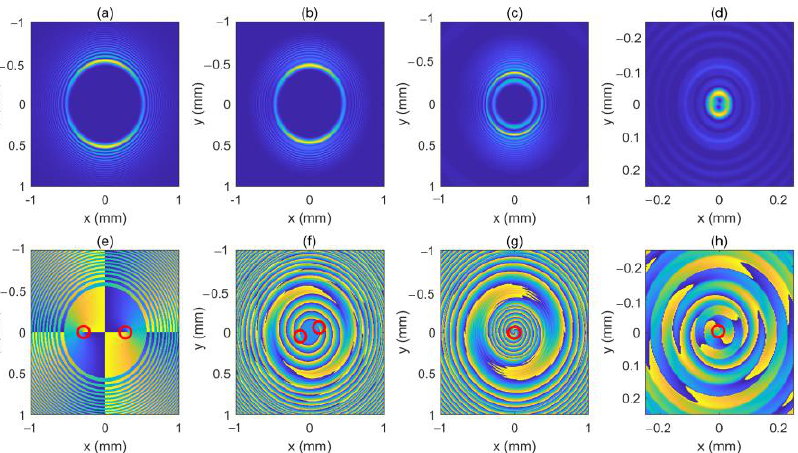
Figure 10. The intensity pattern and phase distribution of the LHCP component at different distances. ( b–d ) show the intensity pattern for z = 50 mm, z = 100 mm, and z = 200 mm; ( f – h ) show the phase distribution for z = 50 mm, z = 100 mm, and z = 200 mm. The intensity pattern and phase distribution of the initial beam are also shown in ( a , e ). The center of the optical vortex (OV) is marked with a red circle.